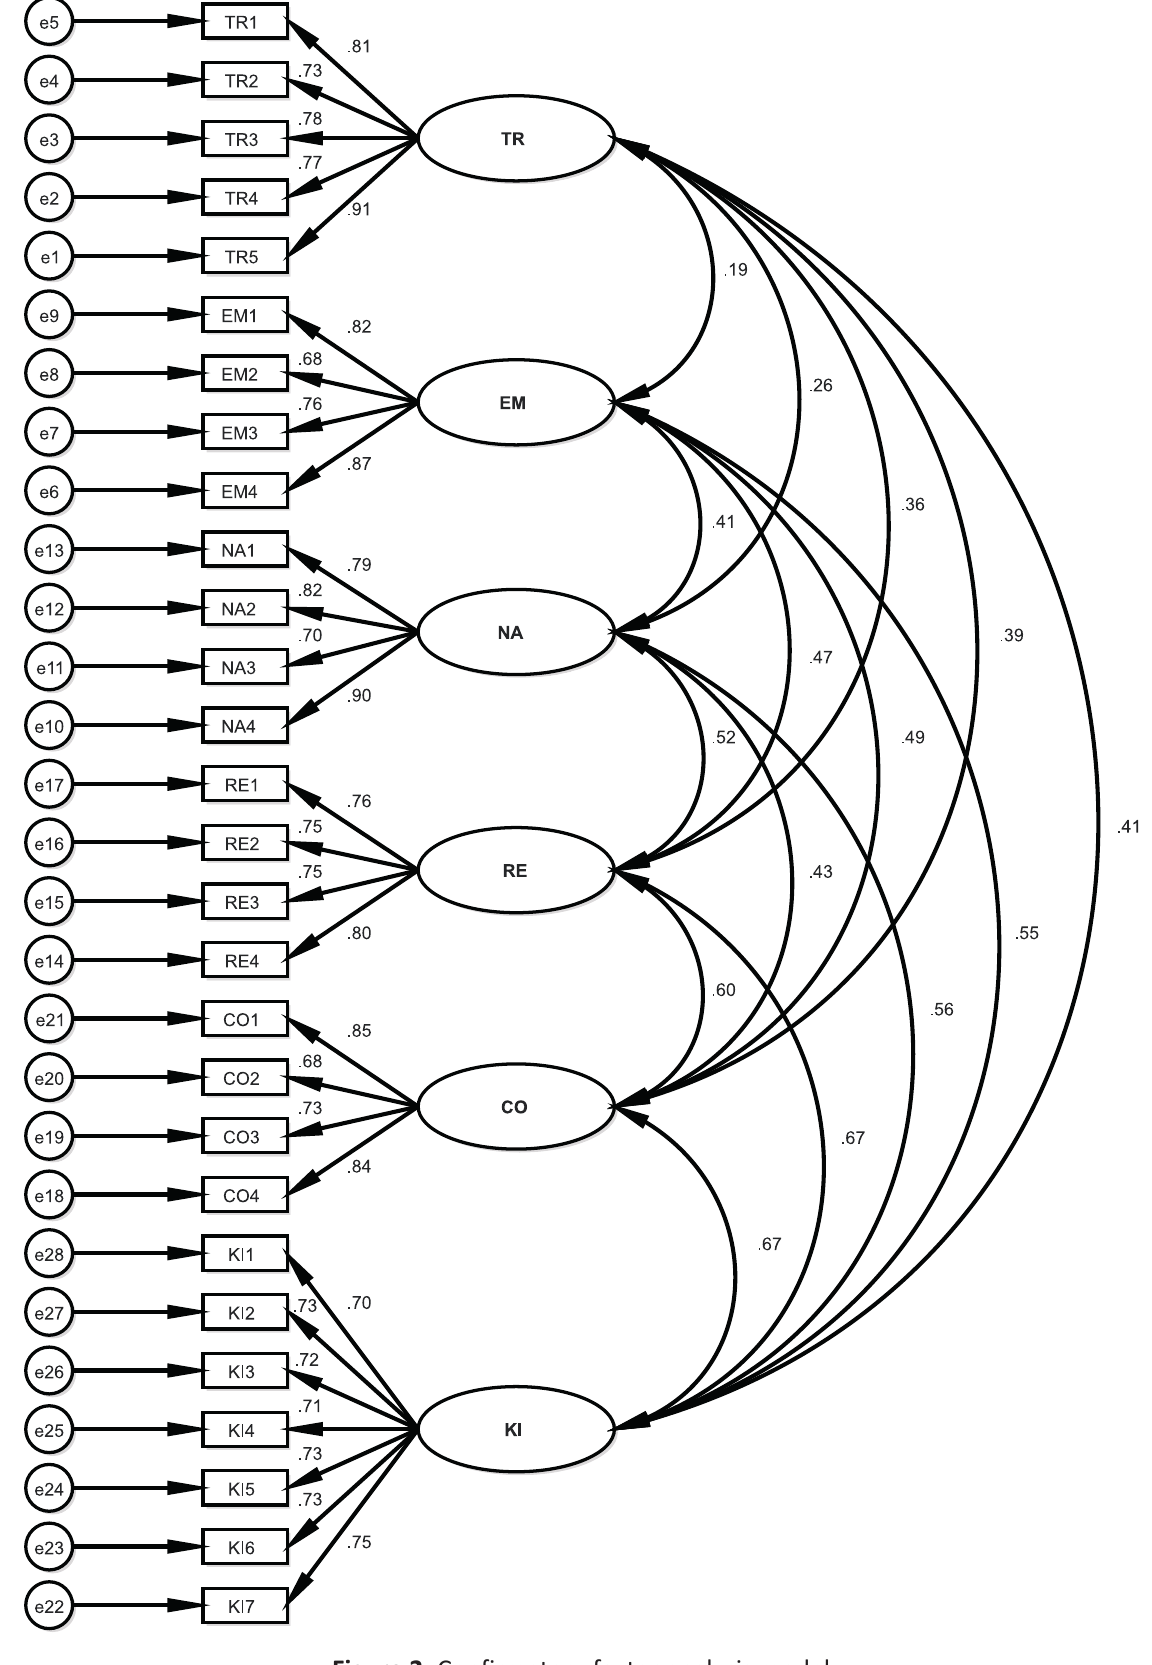
Figure 2. Confirmatory factor analysis